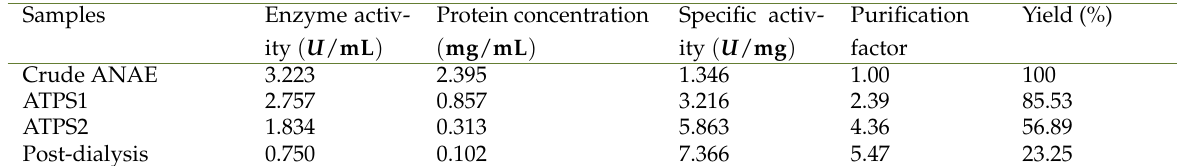
Table 1. ANAE activity assay at different steps of purification